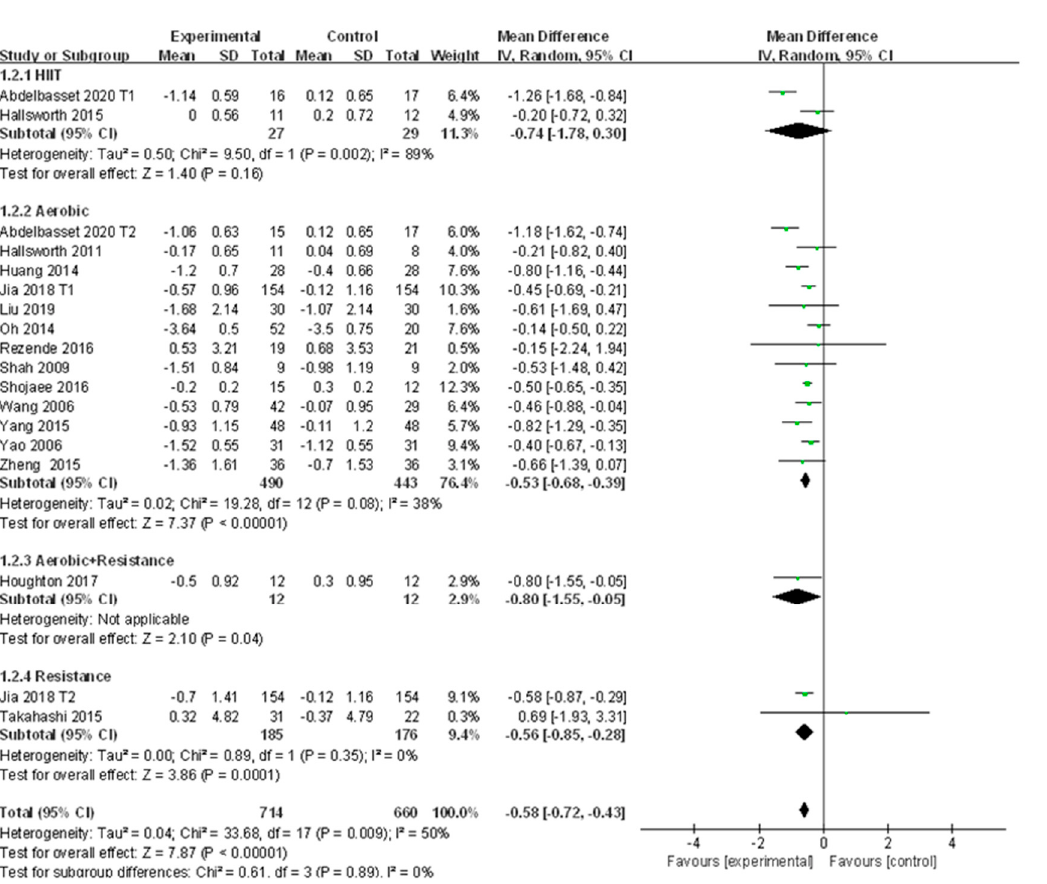
Table 2. Meta regression analysis of heterogeneous factors of TG.